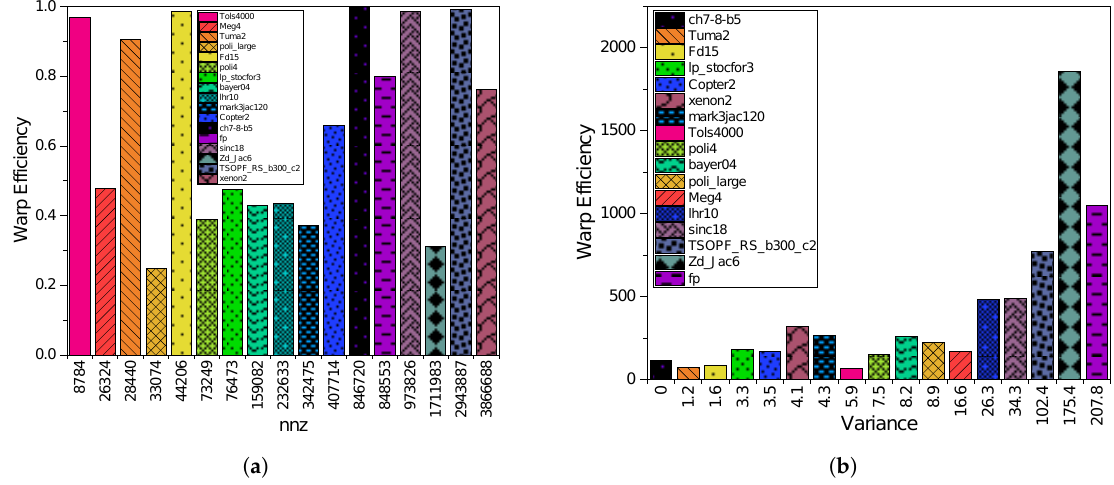
Figure 5. CSR warp efficiency against: ( a ) nnz and ( b ) npr variance